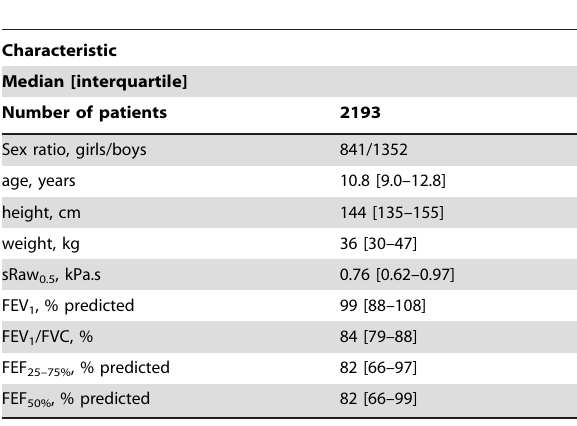
Table 1. Clinical and functional characteristics of the asthmatic children.